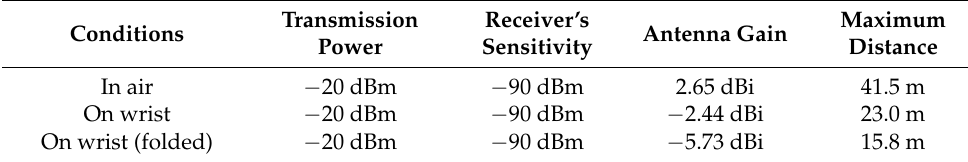
Table 4. Estimated maximum distance of the complete system.